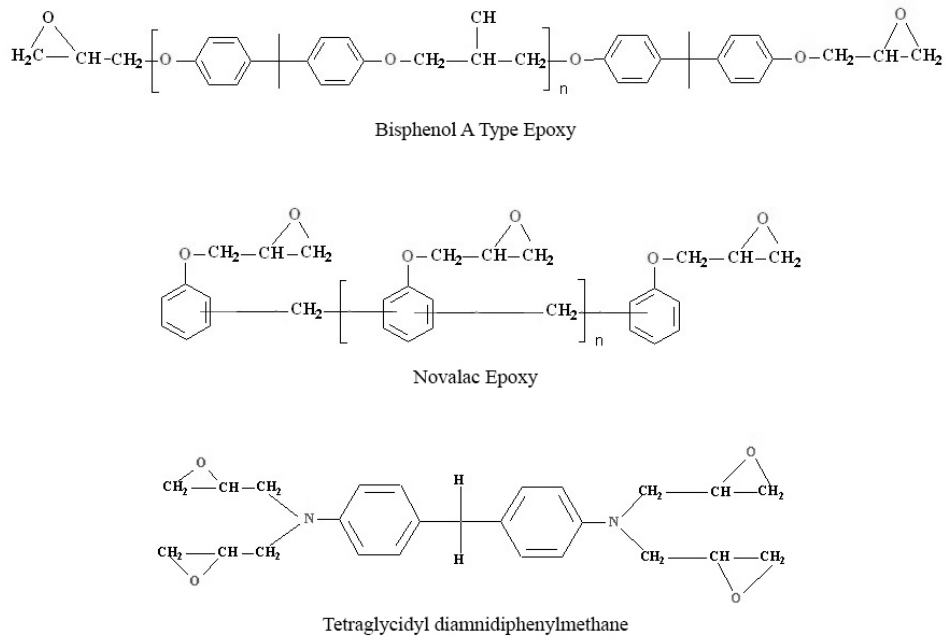
Figure 5. Structure of epoxy system used in this study.